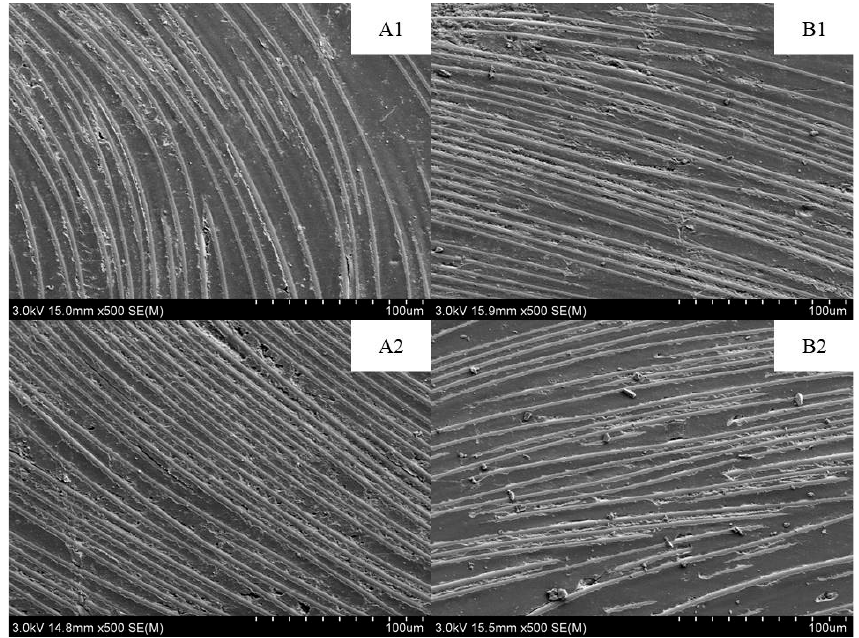
Figure 12. SEM images (at 500× magnification) of the surface morphology of the epoxy pultruded composites before and after ageing (( A1 , A2 ) hygrothermal ageing, ( A1 ) 0 h and ( A2 ) 5280 h; ( B1 , B2 ) salt mist ageing, ( B1 ) 0 h and ( B2 ) 5280 h).